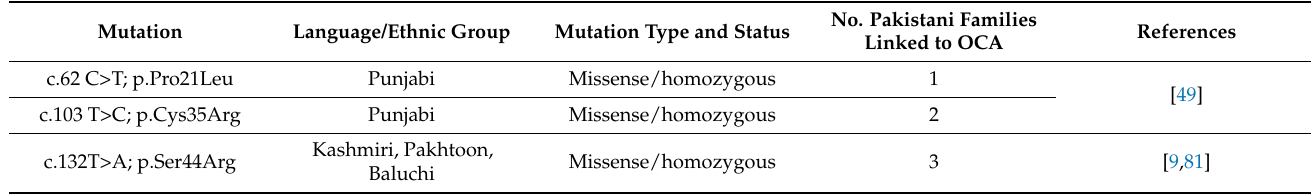
Figure 2. Pakistani families linked to different OCA genes with frequency of mutations. Table 2. List of TYR gene mutations reported in OCA families from Pakistan.